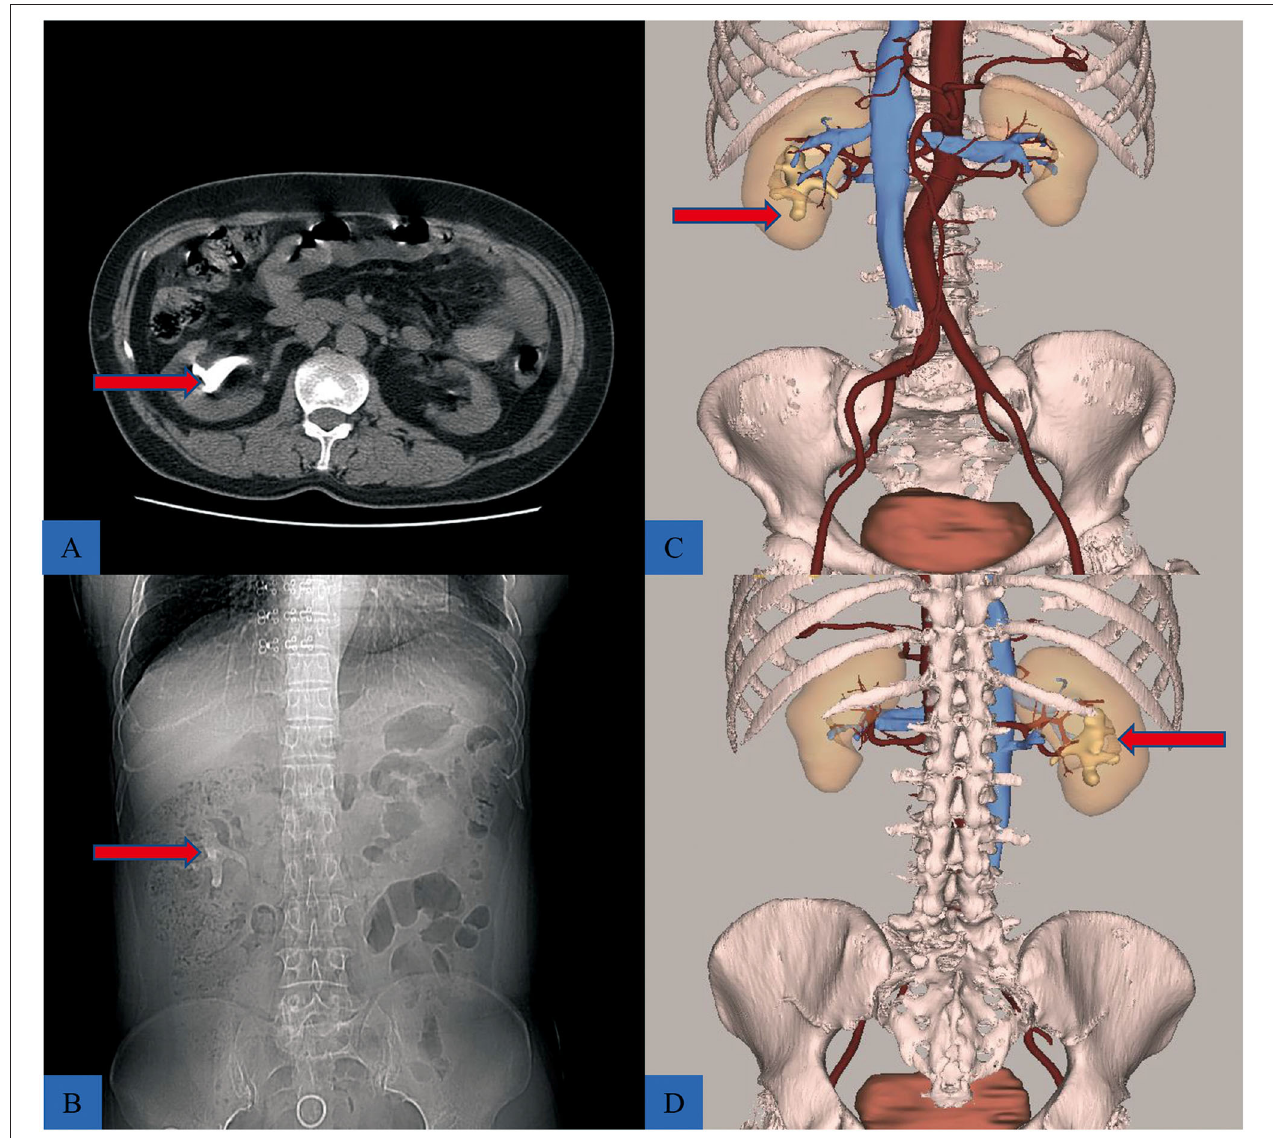
FIGURE 2 | The difference between traditional CT scans, and 3D reconstructive CT scans. (A,B) The CT scan showing a staghorn stone (red arrow). (C) The front view of reconstructive urinary system including calculi (red arrow), kidney, collective system, and blood vessels, hiding the ureter to better reveal the location of the stone. (D) Posterior view of the puncture location, during